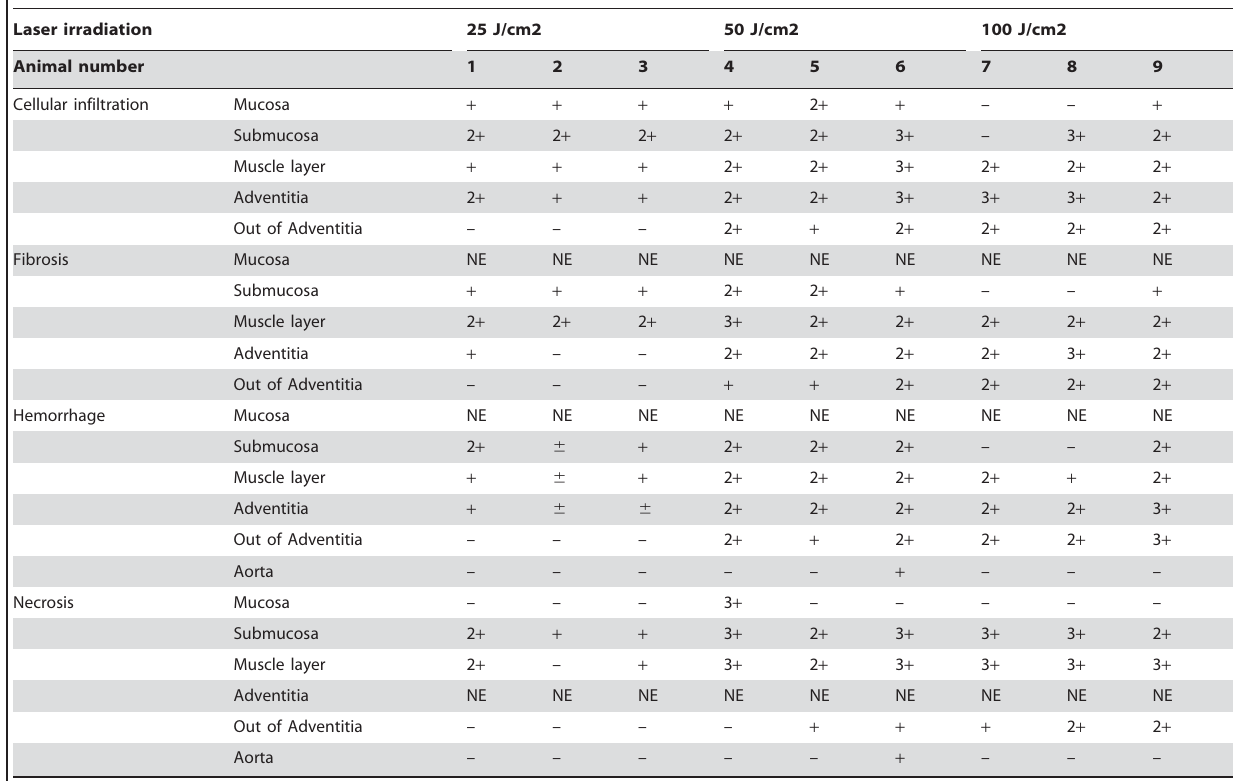
Table 2. Pathological findings in the injury areas.